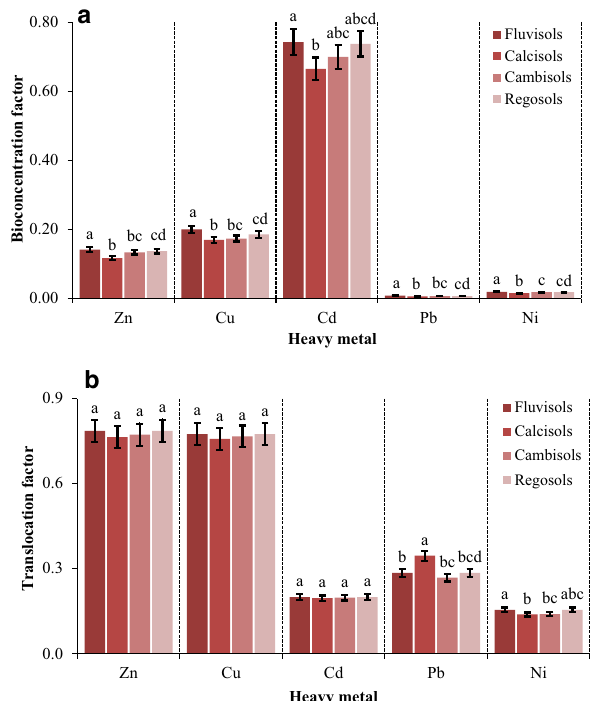
Figure 5. Effect of soil type on the mean bioconcentration factor ( a ) and translocation factor ( b ) of selected heavy metals in urban soils. Different letters indicate significant differences in bioconcentration and translocation factors among soil types for each metal at P < 0.05 confidence